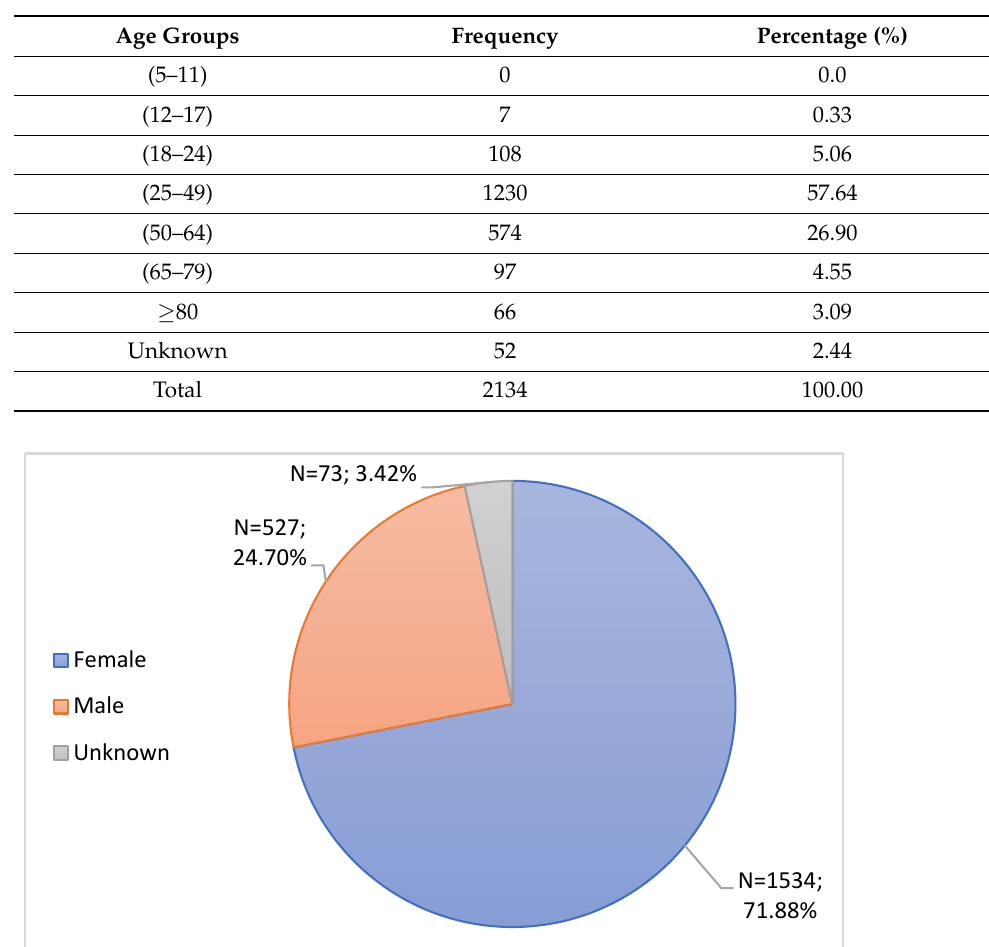
Table 1. Distribution of notifications by age group.